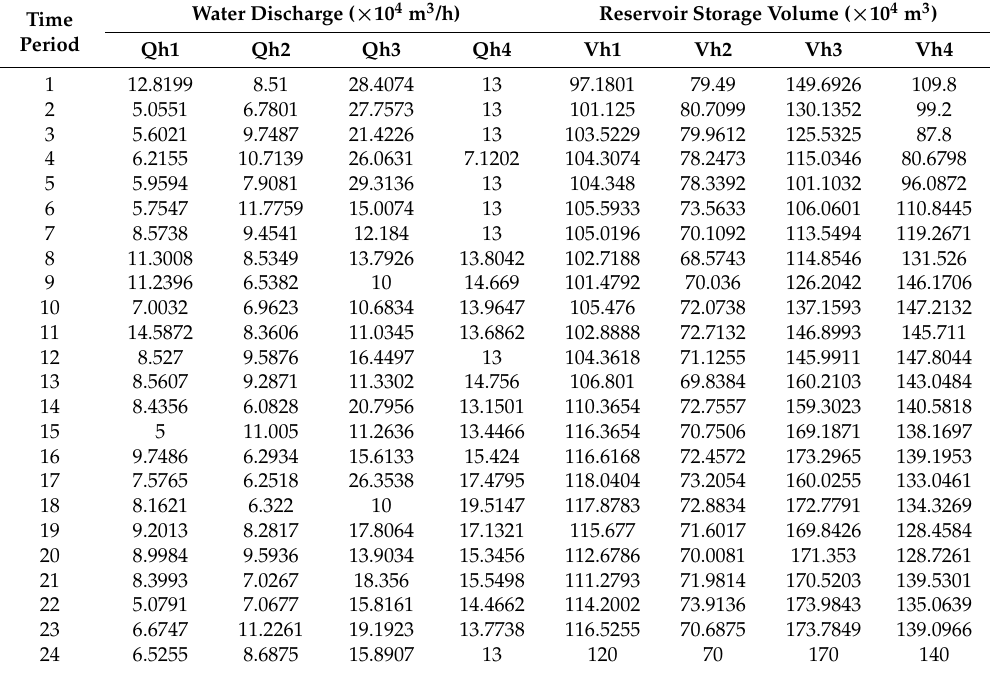
Table 2. Hourly water discharge and reservoir storage volume obtained using the MPSO method. Time Period